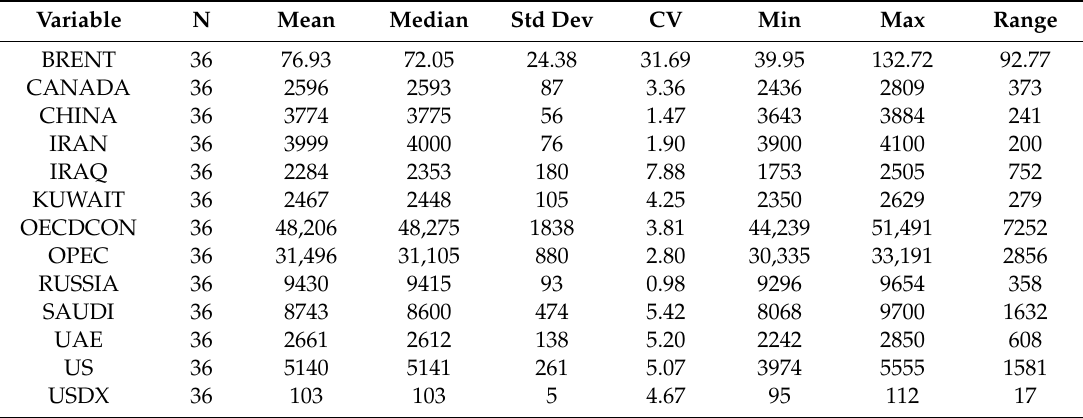
Table 11. Panel 4 period (2007–2009): summary statistics.